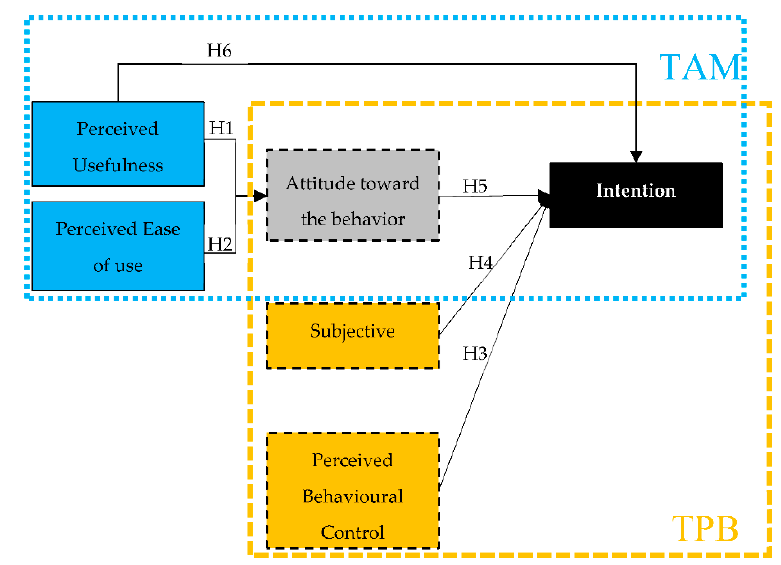
Figure 3. The technology acceptance conceptual model for further investigation.